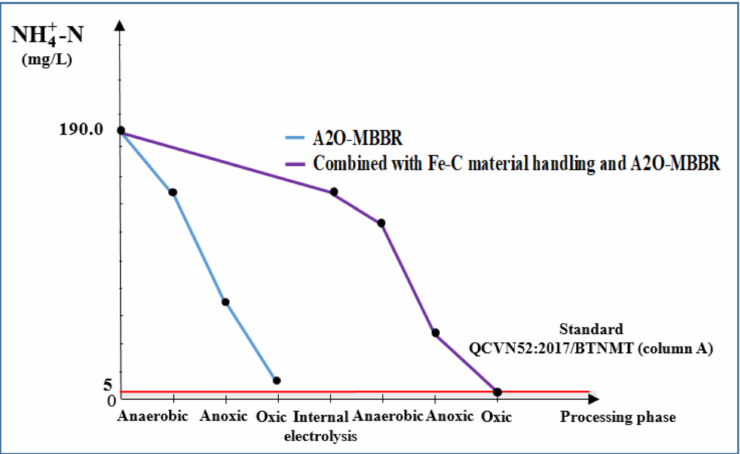
Figure 12. NH + -N treatment e ffi ciency (mg / L) via A2O-MBBR system and through treatment of Fe-C 4 material combined with A2O-MBBR